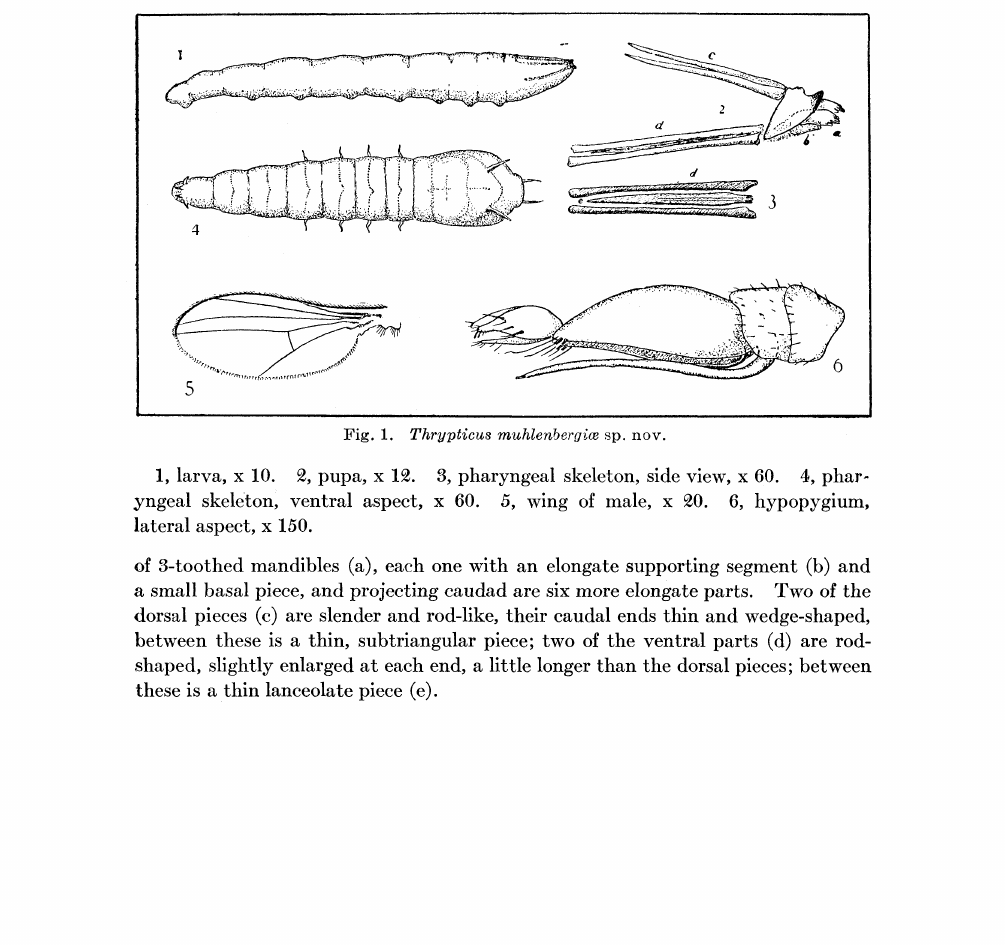
Fig. 1. Thrypticus muhlenbergice